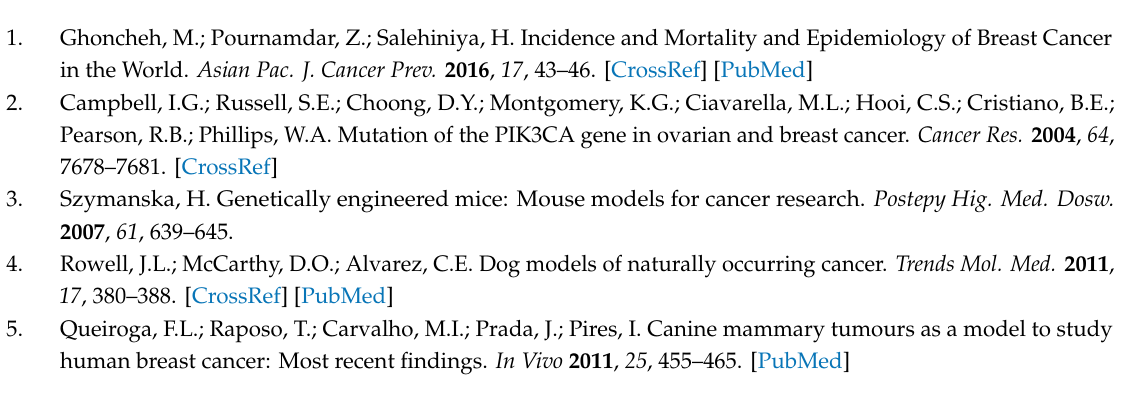
Figure S1: Sequencing QC; Figure S2: Intergenic DMR CpG CG ratio; Figure S3: Canine novel miRNA expression level in CMT; Figure S4: Canine novel miRNA targeted gene expression level in CMT; Figure S5: Estimation of cellular population in normal and cancer PBMCs using cell-type-specific methylated CpG sites; Figure S6: Kaplan–Meier plots of identified target genes and miRNAs; Table S1: Reads’ QC identified DMRs; Table S2: Identified DMRs; Table S3: Assayed number and percentage genomic distribution of DMRs; Table S4: Gene list used in GO and KEGG analysis; Table S5. miRNA DMRs; Table S6: Primer set; Table S7: Target gene UTR homology and ortholog prediction between human and